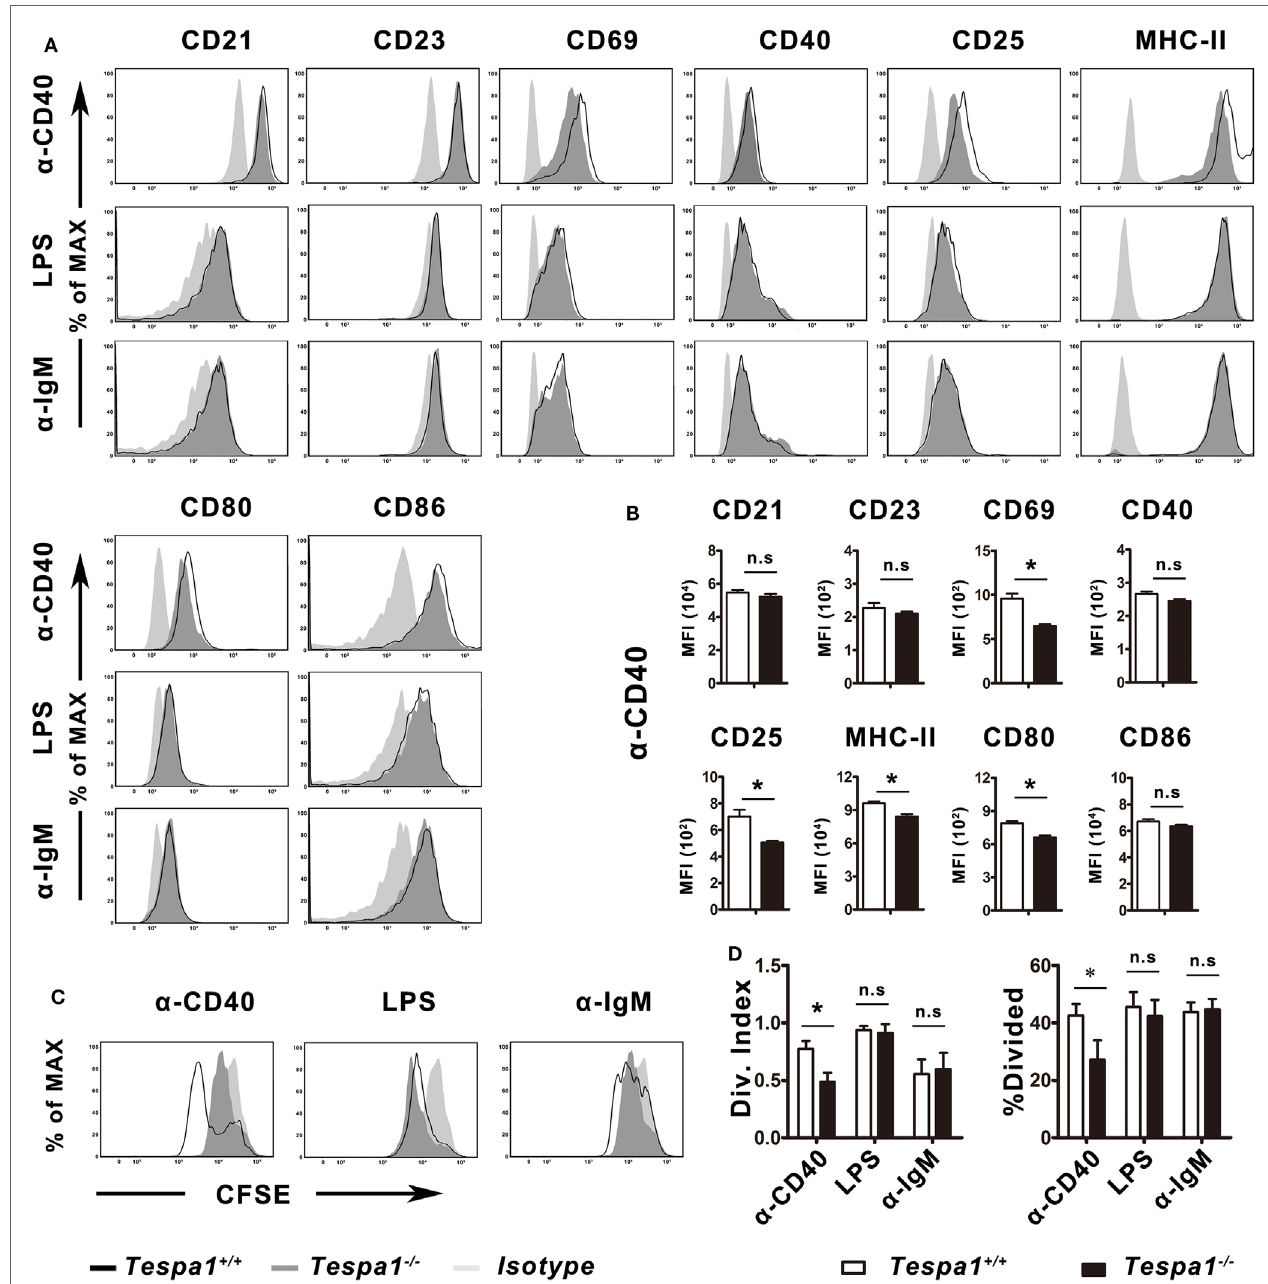
FigUre 4 | Tespa1 deficiency selectively decreases CD40-mediated B-cell activation and proliferation. (a,B) WT (black) and Tespa1 -deficient (gray) B cells were stimulated with α -CD40, LPS, or α -IgM F(ab ′ ) 2 . The expression of CD21, CD23, CD44, CD40, CD25, CD69, CD80, CD86, and MHC-II was analyzed by flow cytometry on B220 + gated cells after 48 h of stimulation with the indicated molecules. (c,D) Carboxyfluorescein succinimidyl ester (CFSE)-stained B cells were stimulated with the indicated antibodies or antigen for 72 h, and proliferation was measured by flow cytometric analysis. Cells were gated on B220 + . Histogram overlays depict the expression of the indicated markers. Summarized data shows the mean ± SEM from three separate experiments ( n = 3), * p <